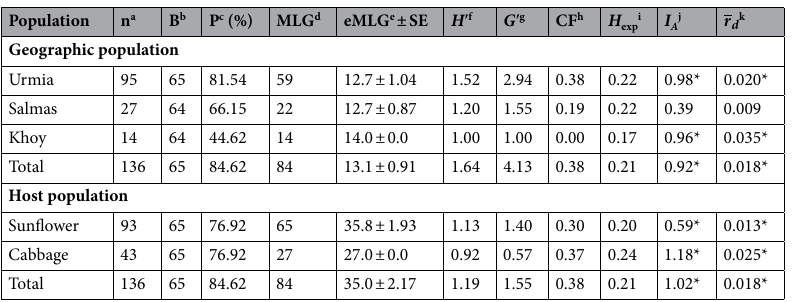
Table 1. Diversity indices and index of association calculated for geographic and host populations of Sclerotinia sclerotiorum . a Number of isolates. b Number of polymorphic bands. c Percentage of polymorphic bands. d Number of multilocus genotypes. e Expected number of multilocus genotypes. f Corrected Shannon– Weaver index of MLG diversity [ H / ln (eMLG)]. g Corrected Stoddart and Taylor index of MLG diversity ( G / eMLG). h Clonal fraction. i Nei’s unbiased gene diversity. j Index of association. k Standardized index of association. *Significance at p <